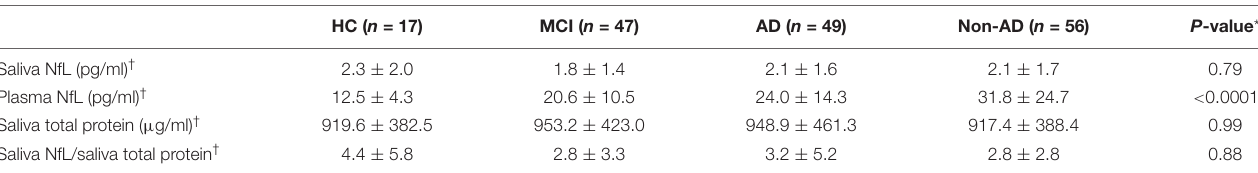
TABLE 2 | Mean levels of the biomarkers in saliva and plasma.